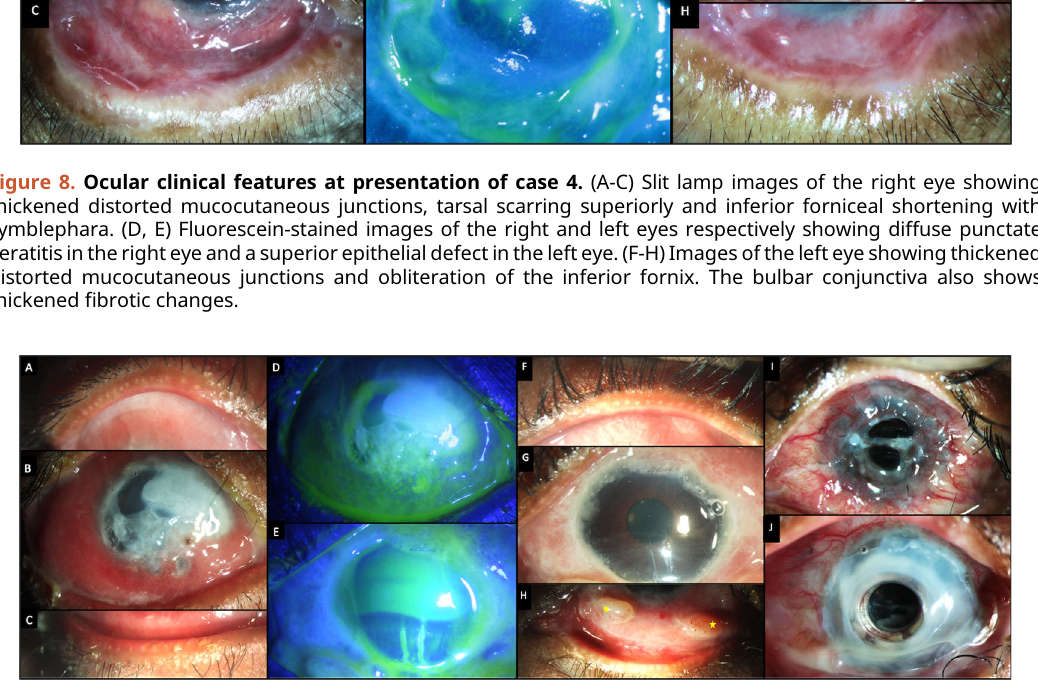
Figure9.Clinicalfeaturesatpresentationofcase5. (A-C)Slitlampimagesoftherighteyeshowingcongestionand chemosis with significant collagenolysis in the cornea. (D, E) Fluorescein-stained images of the right and left